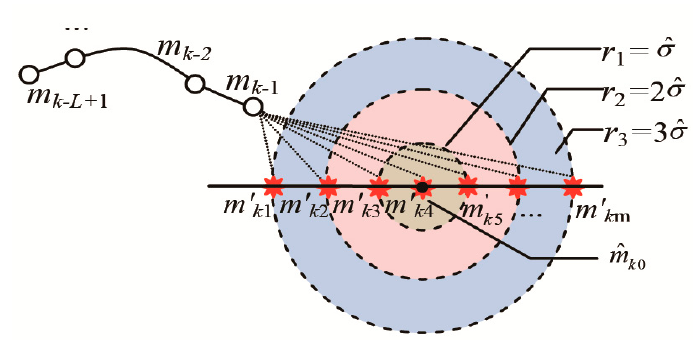
Figure 3. Basic idea of RM-PDA-ICCP algorithm.